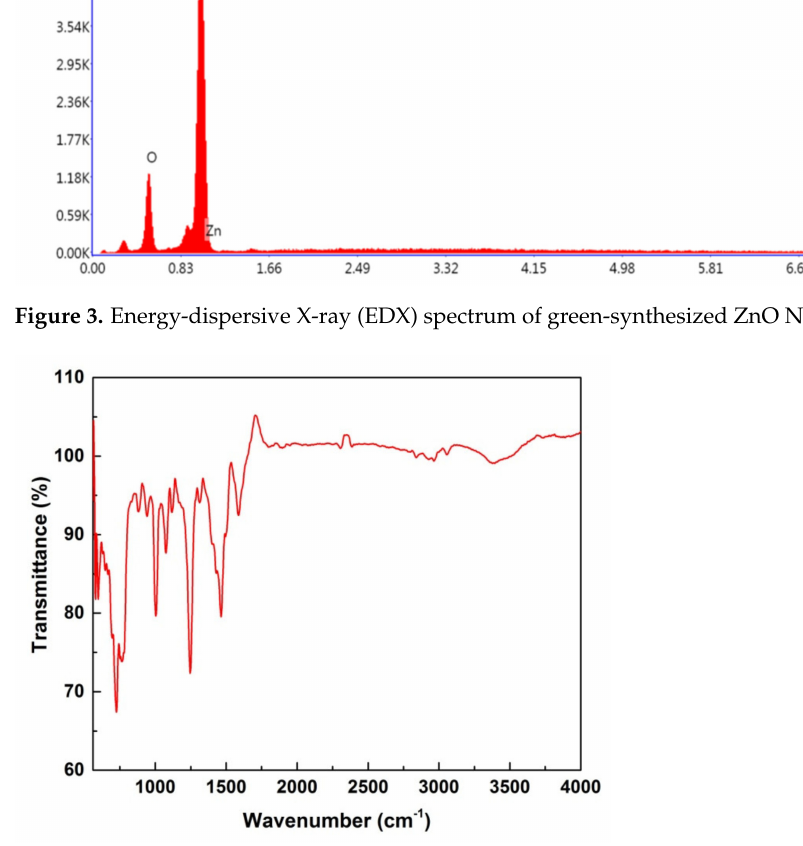
Figure 4. FT − IR analysis of ZnO